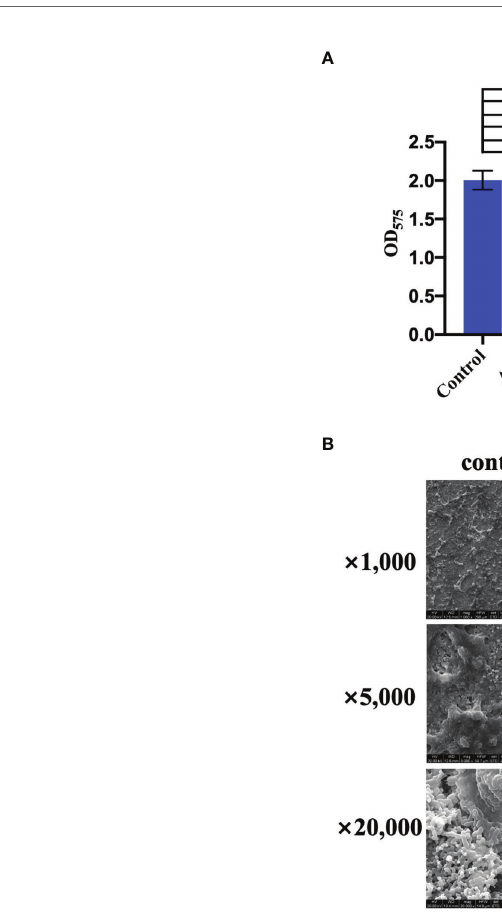
FIGURE 3 | Effect of different levels of 1,3-bis[3,5-bis(tri fl uoromethyl)phenyl]urea (BPU) on bio fi lm formation of Streptococcus mutans UA159. (A) Biomass of bio fi lms quanti fi ed with crystal violet staining assay. (B) Representative SEM images of bio fi lms treated with 1 and 2 µg/ml of BPU or acetonitrile (control). Means ± SDs from three independent experiments are shown. **** indicates p <